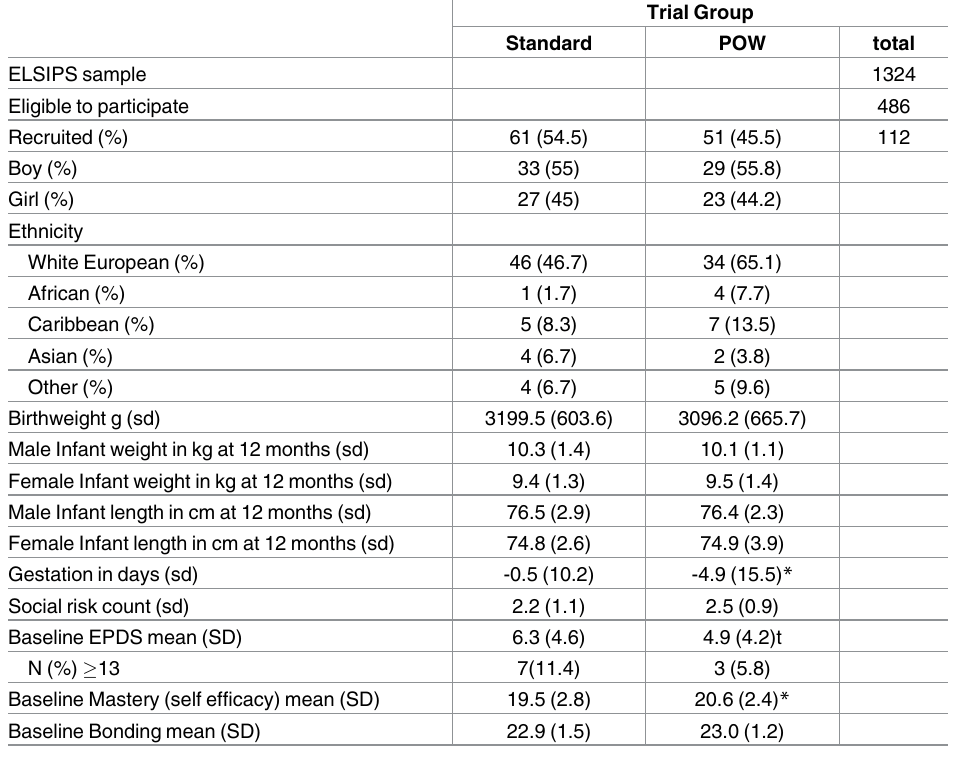
Table 2. ELSIPS sollow up sample composition and